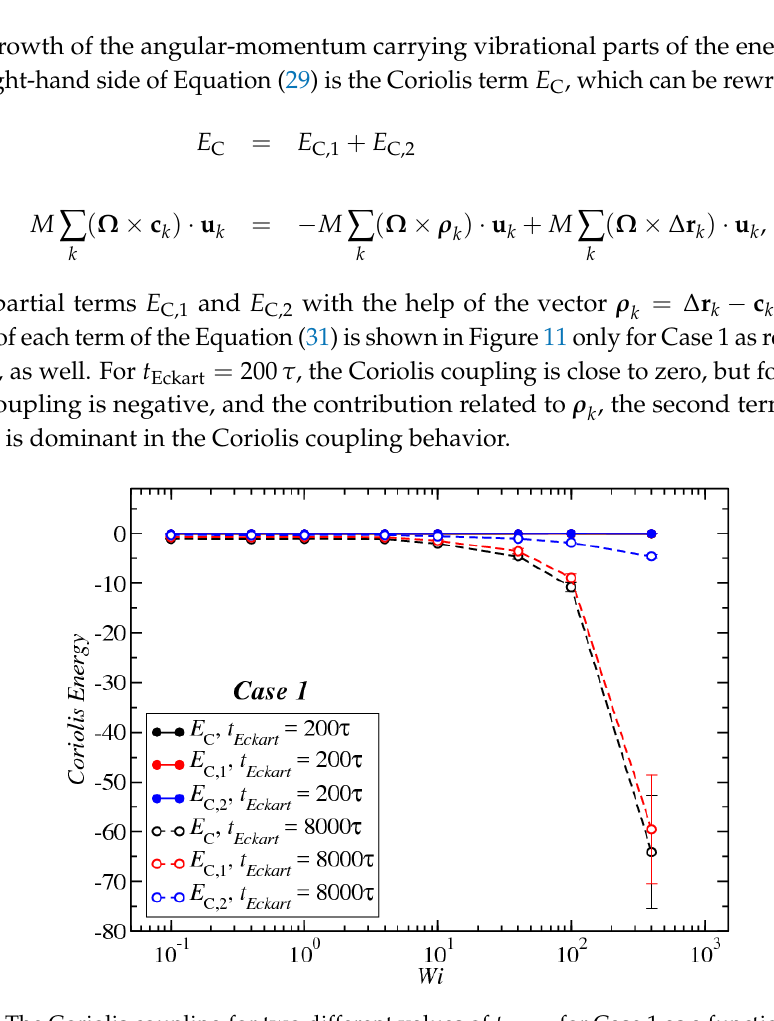
Figure 11. The Coriolis coupling for two different values of t Eckart for Case 1 as a function of Wi .